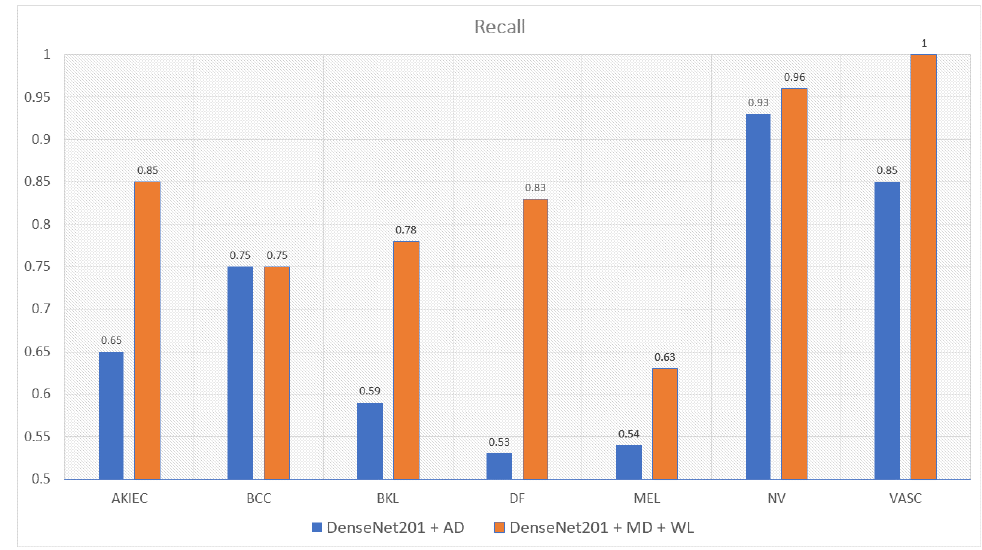
Figure 14. The comparison between recall of DenseNet201 trained with augmented data and the one trained with metadata and weight loss.